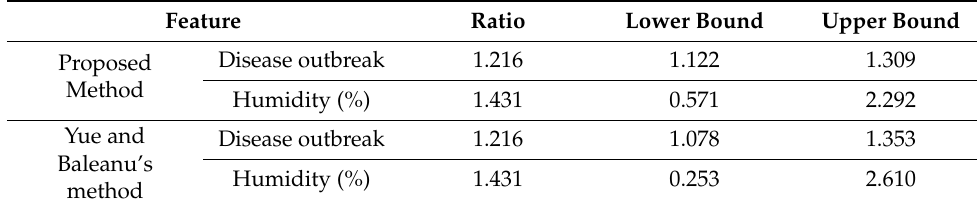
Table 7. The lower and upper bounds of the computed confidence intervals for the ratio of the CV of the humidity and the ratio of the CV of the scale of hand, foot and mouth disease outbreak in Malacca with respect to